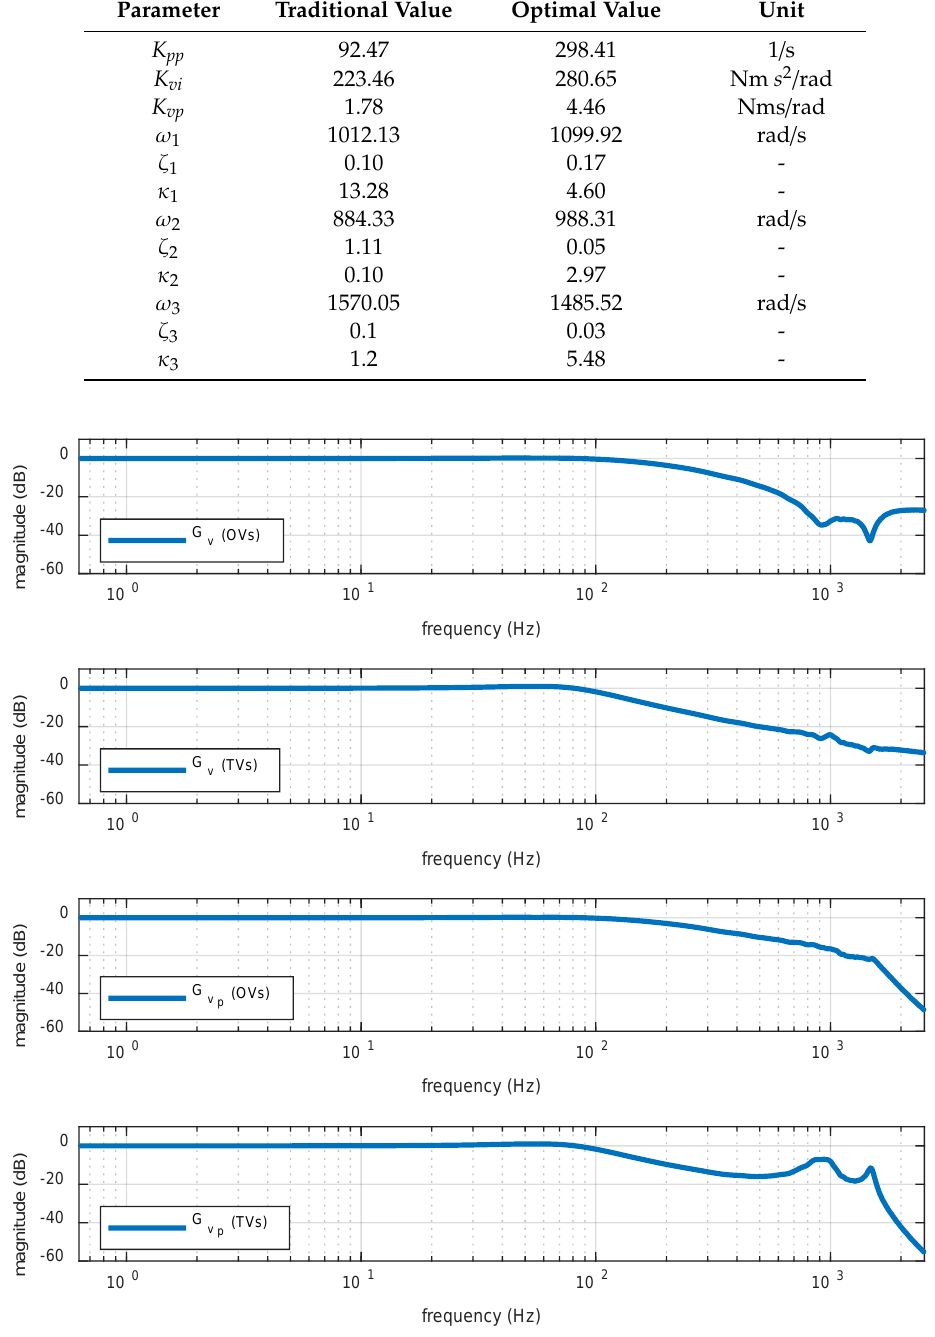
Figure 7. Magnitude plot of G v and G vp with TVs and